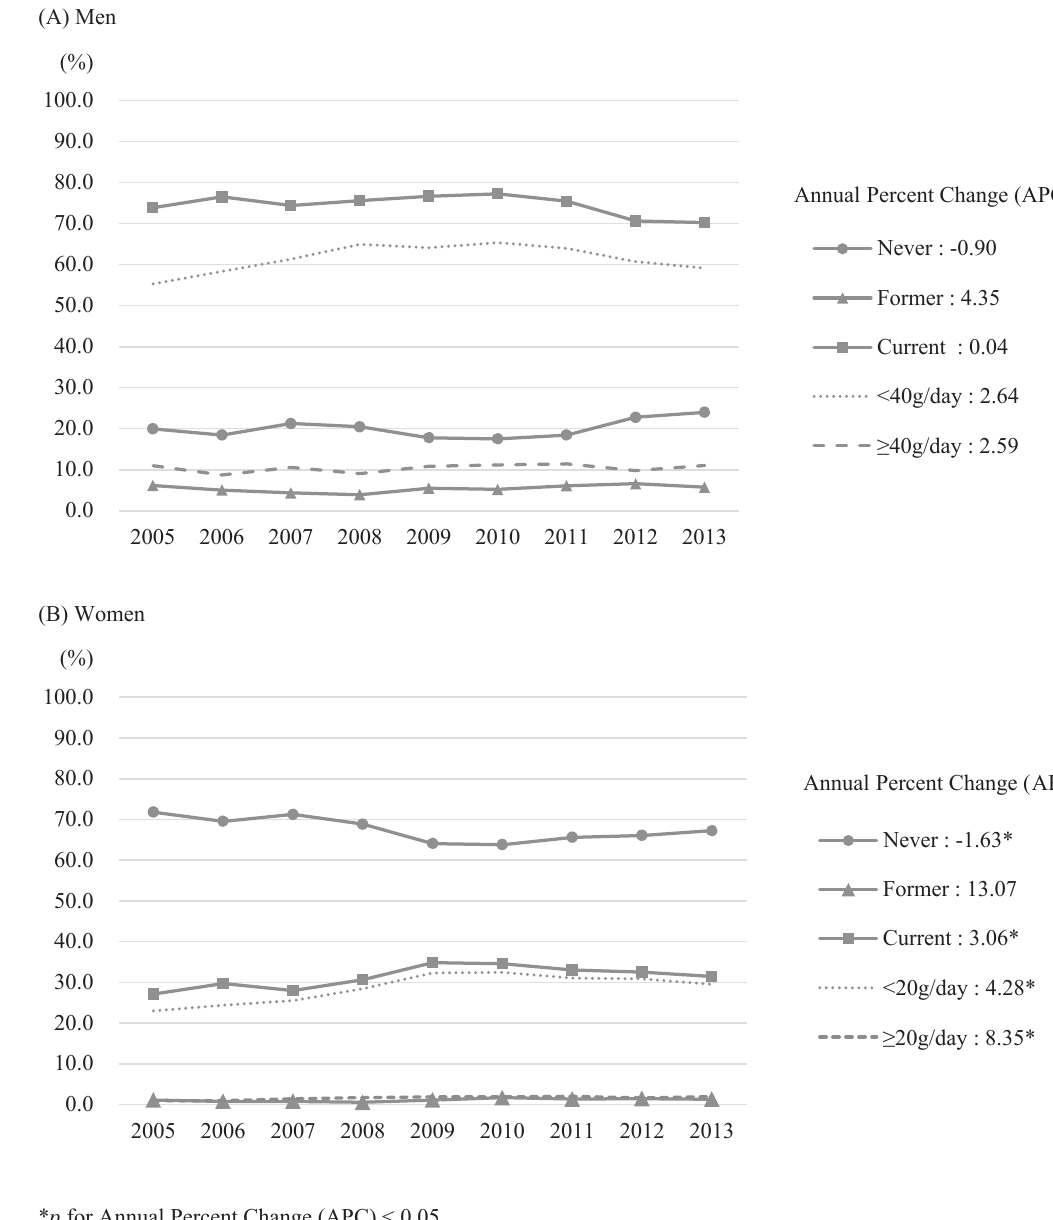
Figure 1. Trend of age-standardized prevalence of alcohol consumption among 43,927 men and 85,897 women aged 40 – 69 years in HEXA-G study from 2005 through